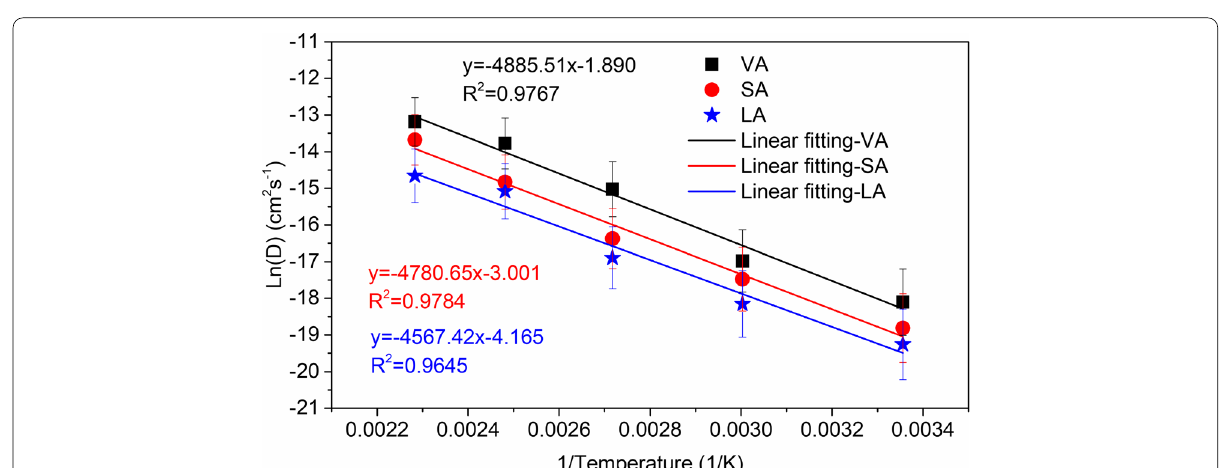
Fig. 20 Diffusion Coefficient versus Simulation Temperatures for Virgin Asphalt, Short-Term Aged Asphalt, and Long-Term Aged Asphalt